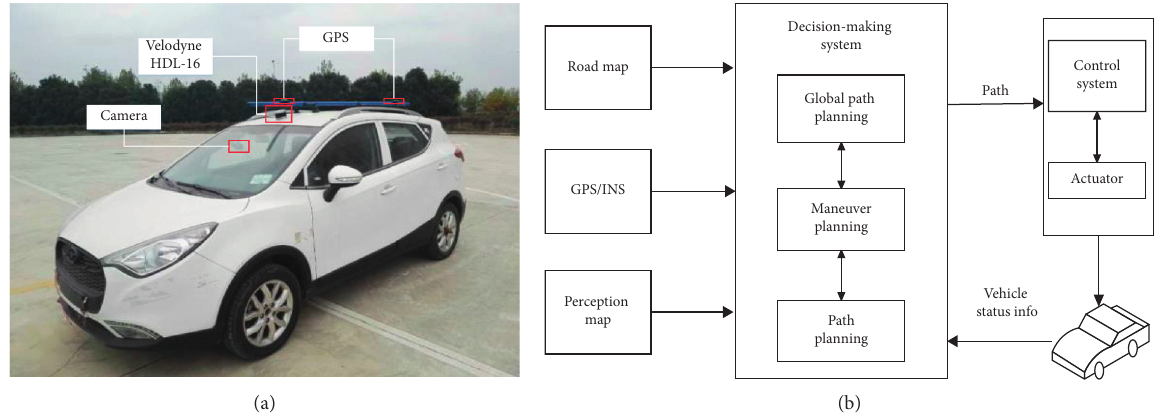
Figure 1: (a) The sensor configuration of the autonomous vehicle. (b) The software architecture of planning system. Global grid map